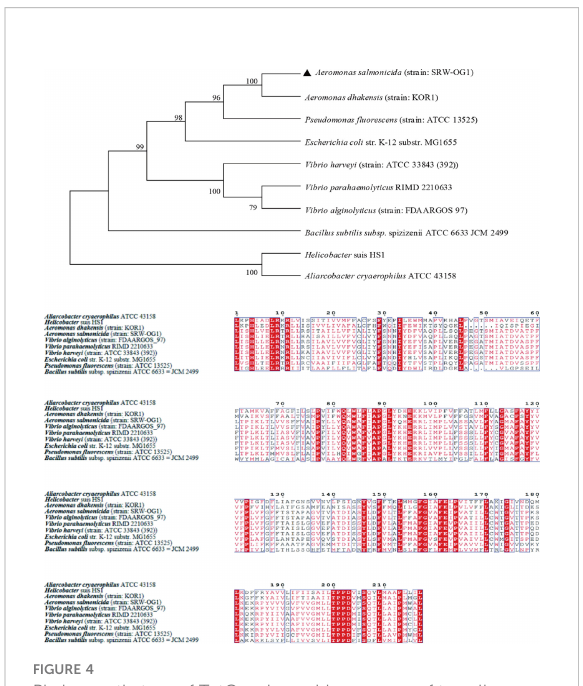
FIGURE 4 Phylogenetic tree of TatC amino acid sequence of type II secretion